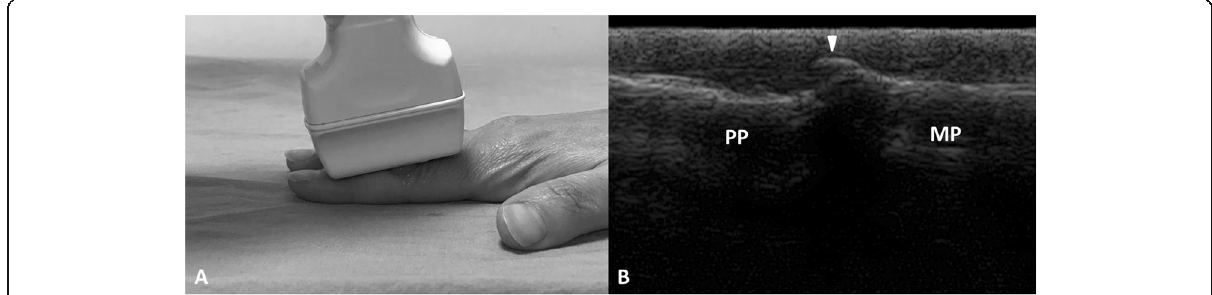
Fig. 1 a Probe positioning for dorsal longitudinal view of proximal interphalangeal joint. Same positioning applied for examination of distal interphalangeal and 1st interphalangeal joints. b An osteophyte formation (arrowhead) observed as a cortical protrusion in proximal interphalangeal joint. MP: middle phalanx, PP: proximal